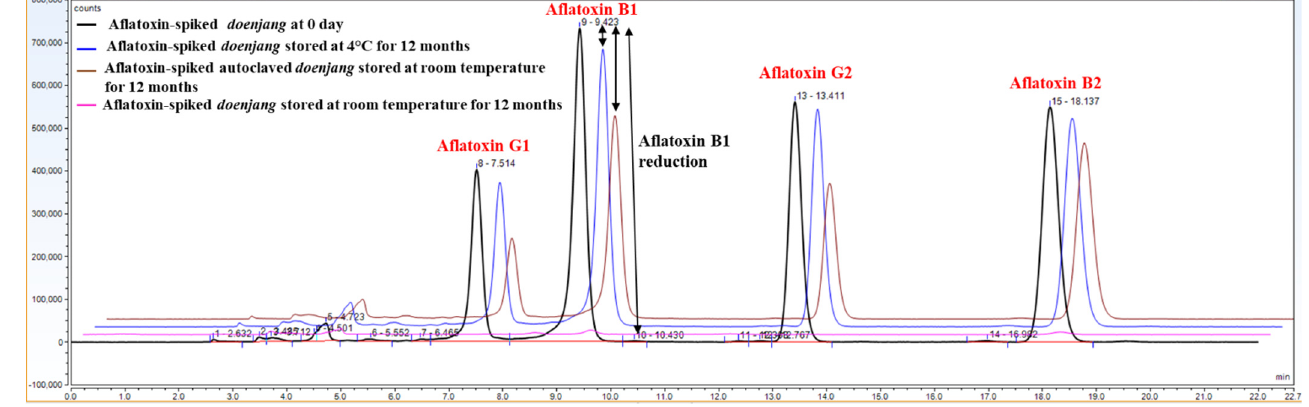
Figure 4. HPLC chromatograms representing aflatoxin levels in doenjang spiked with 100 µg/kg each of aflatoxins B1, G1, B2, and G2 on Day 0 and after 12 months of storage at 4 °C and room temperature (25 ± 2.5 °C).